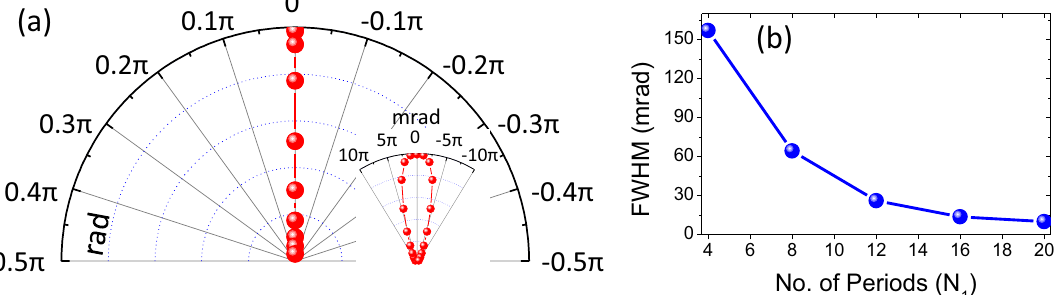
Figure 6. ( a ) Emissivity patterns in polar coordinates at the operating wavelength for the proposed thermal emitter; ( b ) variation of the emission lobe beamwidth with N 1